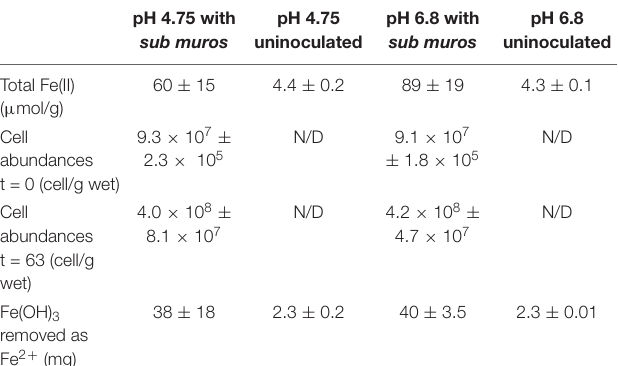
TABLE 1 | Post mortem analysis of column